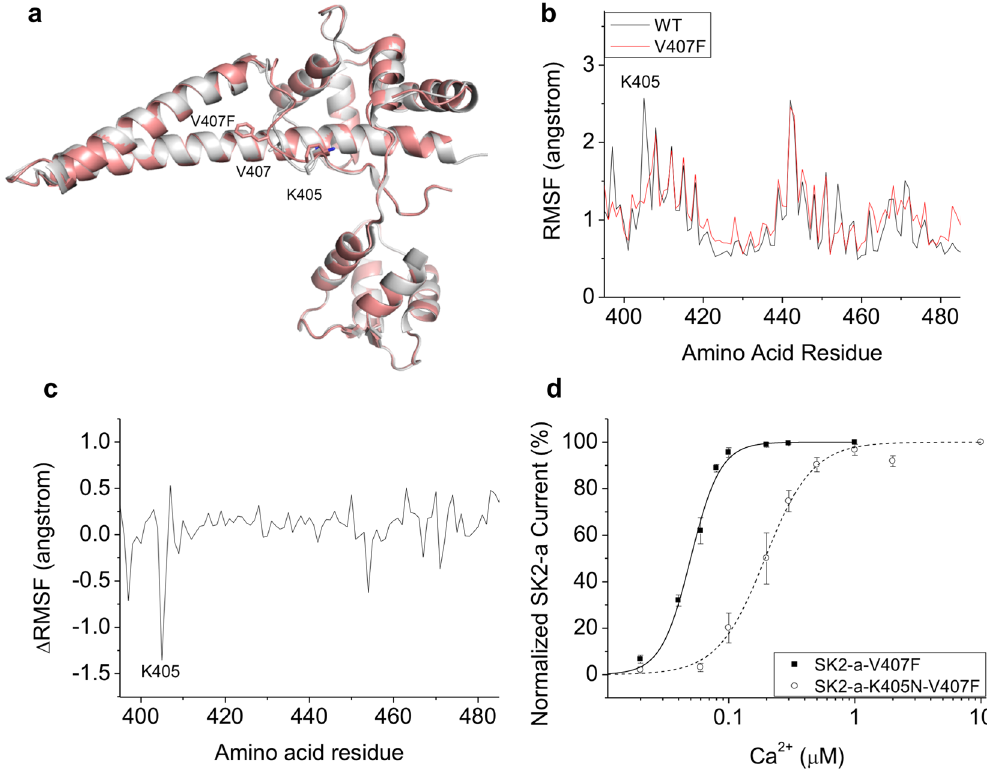
Figure 3. V407F stabilizes K405. ( a ) Overlaid crystal structures of WT (grey) and V407F (salmon) protein complexes show similar global conformation. ( b ) In MD simulations, the RMSF plot shows the difference in the structural flexibility of the residues between the WT and V407F mutant structures. ( c ) The difference RMSF plot ( Δ RMSF = RMSF (V407F) − RMSF (WT) ) shows the reduced structural flexibility of K405 in the IDF of the V407F mutant structure. ( d ) Neutralizing mutation K405N right-shifts the dose-dependent activation of the V407F mutant SK2-a channel by Ca 2 + . Statistical analysis was performed using two-tailed t -test. All data are presented in mean ±